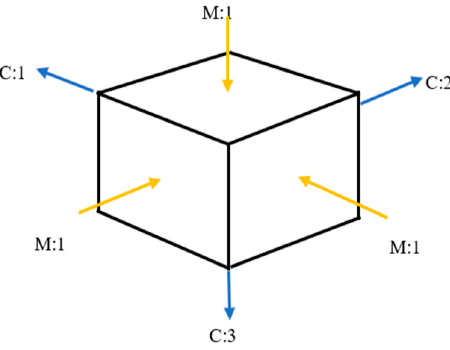
Figure 13. Distribution of excitations and signal response points on the research object.(C and M: the names of axels in software).